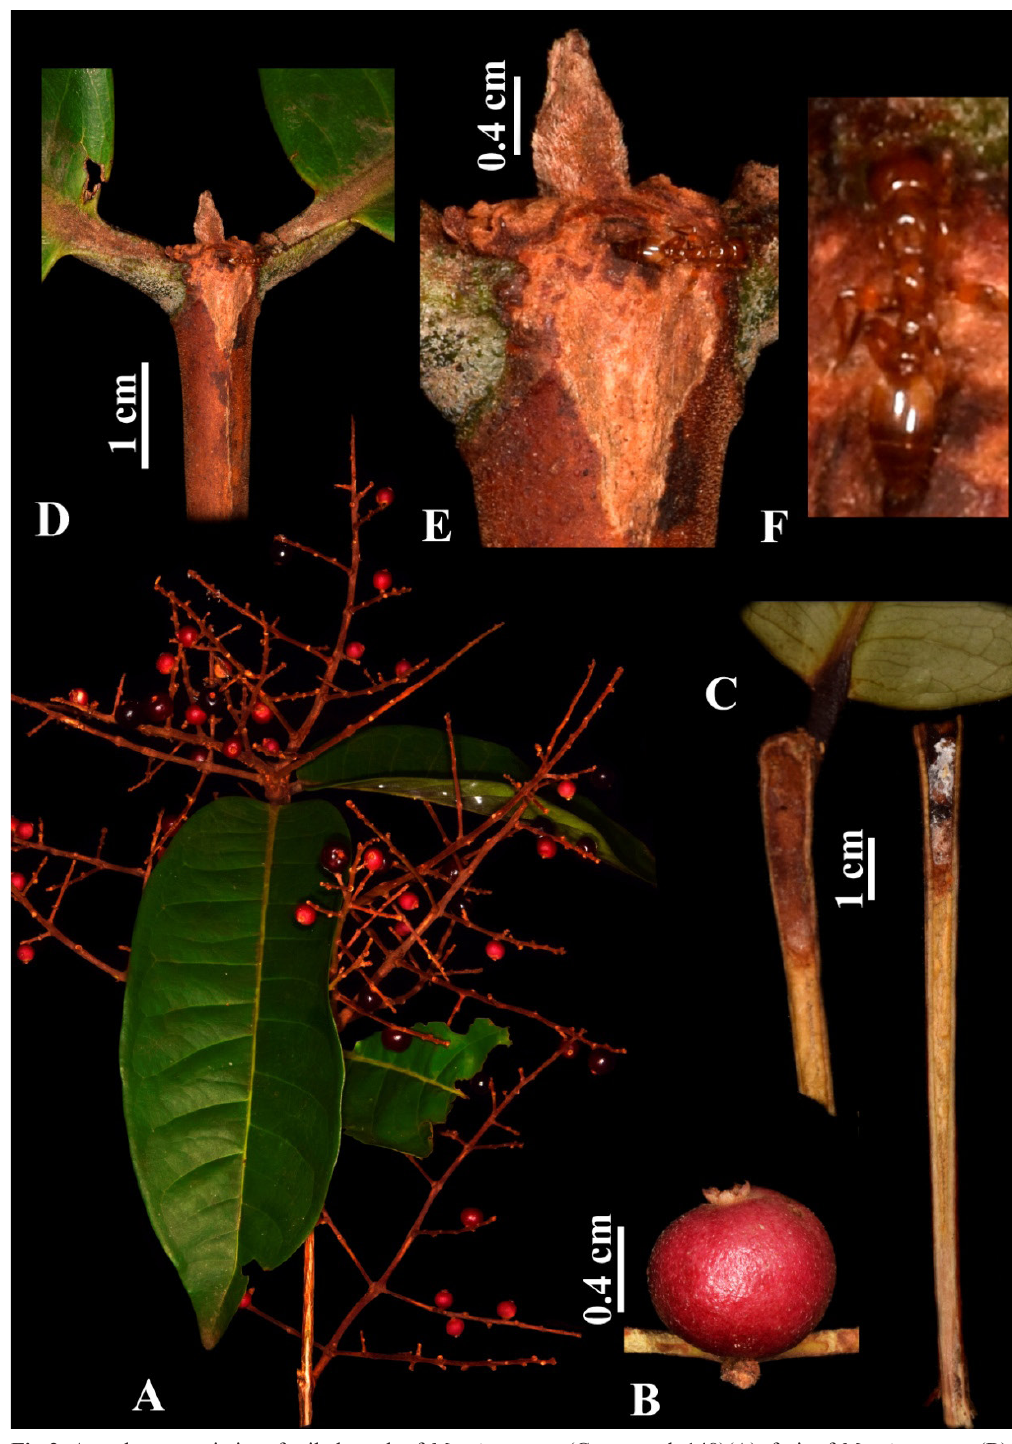
Fig 2. Ant-plant association: fertile branch of Myrcia magna (Gaem et al. 148)(A), fruit of Myrcia magna (B), longitudinal section of a domatium (C), a domatium just below a node (D), an individual of Myrcidris epicharis (F. Farroñay, CZPB) getting out of a domatium (E), and detail of an ant